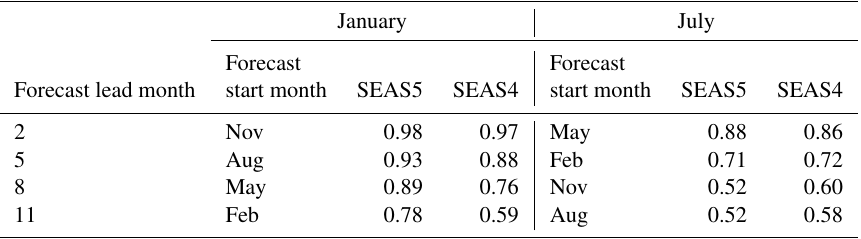
Table 3. Niño 3.4 anomaly correlation values for the annual-range forecast using the ensemble mean of 15 ensemble members, listed as a function of lead time (months) for two verifying months (January and